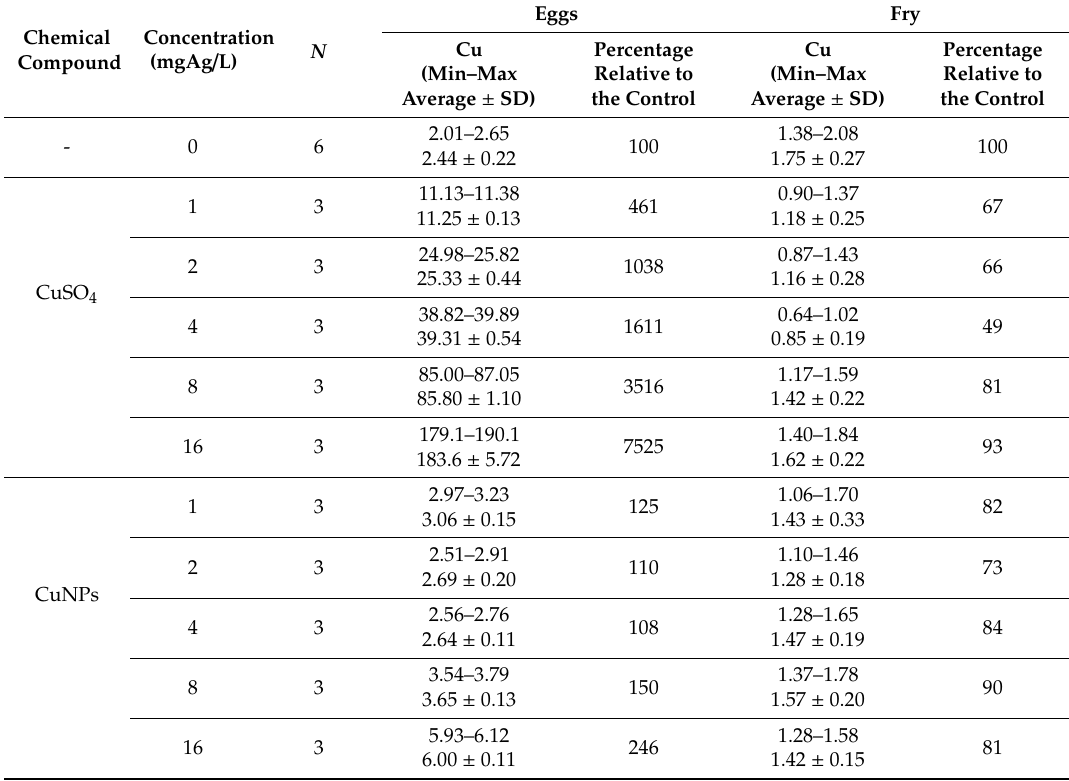
Table 5. Copper nanoparticles (CuNPs) and ions (Cu + 2 ) content of the rainbow trout eggs and fry (mg / kg w.w.) after an application of different concentrations of Cu in the forms CuSO 4 or CuNPs (mgCu / L). Concentration Chemical (mgAg / L) Compound